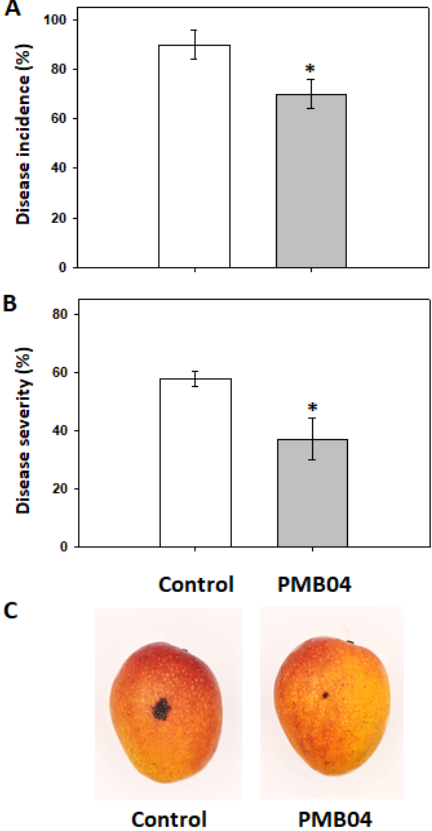
Figure 2. Application of Bacillus amyloliquefaciens PMB04 bacterial suspension against anthracnose disease in mango fruit. ( A , B ) show the disease incidence and disease severities at 7 days post-inoculation. The surfaces of sterilized fruit were soaked in the bacterial suspension of B. amyloliquefaciens PMB04 for 1 min as the treatment. The control was performed with sterilized water as a negative control. A spore suspension of Colletotrichum gloeosporioides was then spotted on the surface of the fruit for inoculation. Data represent mean ± SD. The asterisks indicate a significant difference compared with the control treatment, as assessed using a t -test ( p < 0.05). ( C ) shows the symptom appearances of different treatments on the fruit.